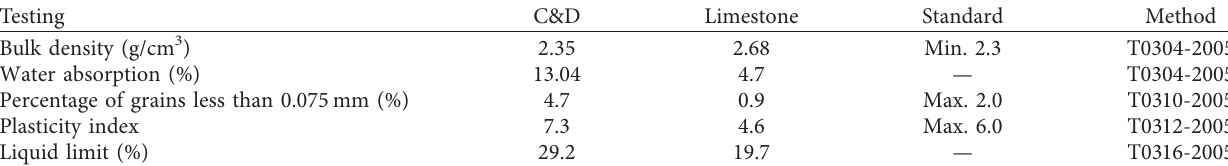
Table 3: Physical properties of fine